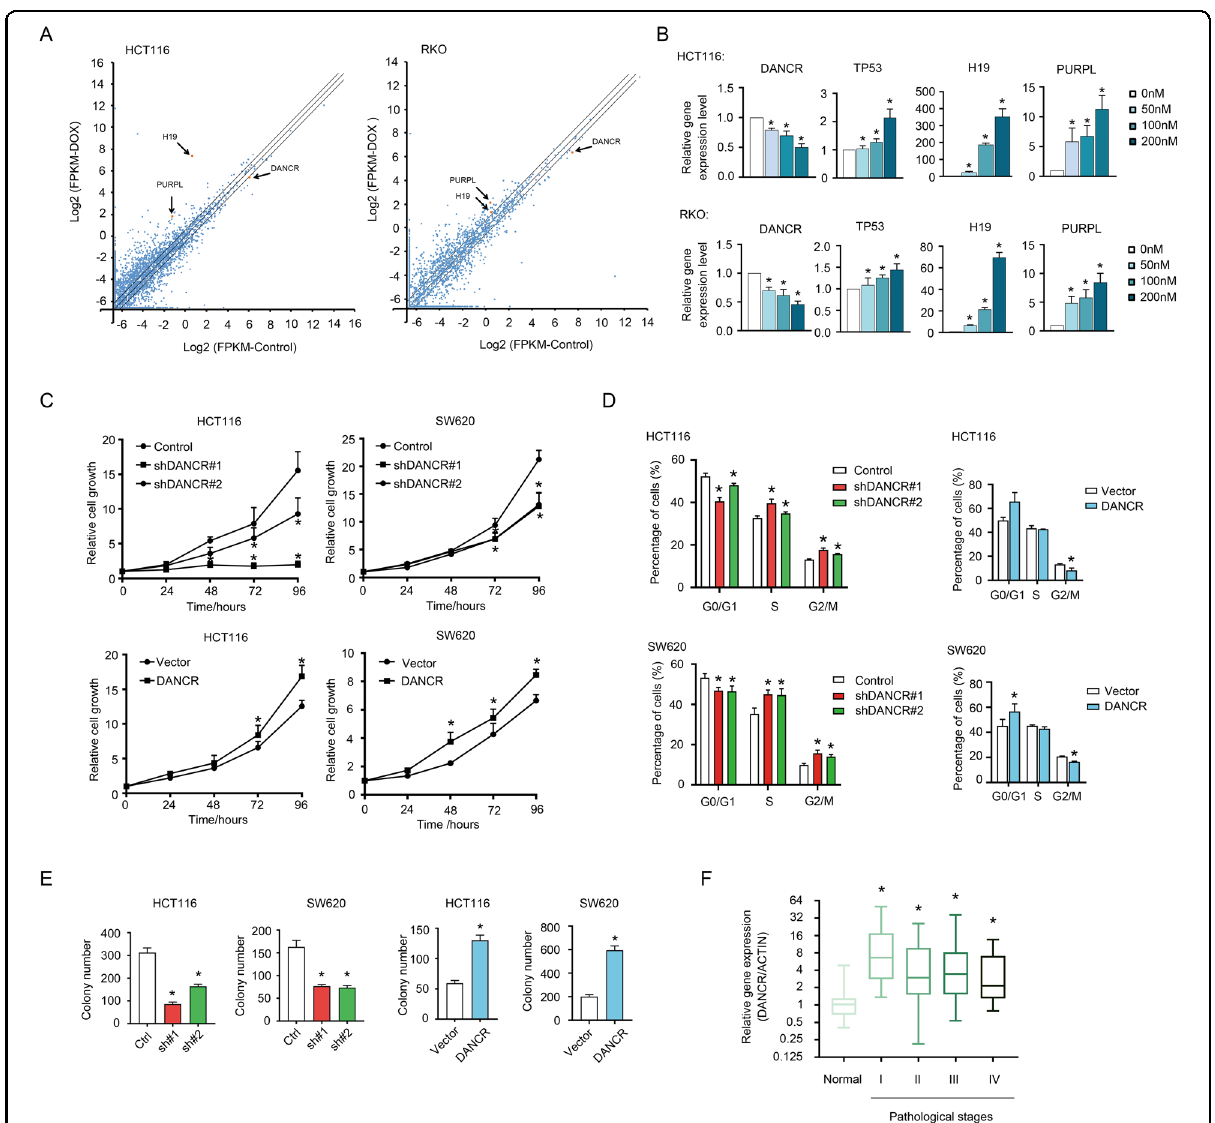
Fig. 1 DANCR was closely correlated with cell growth and tumor progression in colorectal cancer. A Changes in lncRNA expression in HCT116 and RKO cells upon Dox treatment were presented in Scatter Dot Plots. X axis: log 2 (FPKM) of control cells; Y axis: log 2 (FPKM) of Dox-treated cells. Arrows indicated lncRNAs DANCR, PURPL, and H19, whose fold changes were higher than 1.5-fold. B The expression levels of DANCR, TP53, H19, and PURPL were detected by qPCR in HCT116 (top) and RKO (bottom) cells treated with increasing dosages of Dox (0, 50, 100, 200 nM) for 24 h. * p < 0.05. C DANCR knockdown inhibited HCT116 and SW620 cells proliferation (top), whereas DANCR overexpression promoted the growth of HCT116 and SW620 cells detected by CCK8 assays (bottom). * p < 0.05. D Cell cycle progression was analyzed using fl ow cytometry in HCT116 and SW620 cells with shDANCR or DANCR overexpression vectors. * p < 0.05. E The anchorage-independent growth capacity of HCT116 and SW620 cells was impaired upon DANCR knockdown, and it was enhanced in HCT116 and SW620 cells overexpressing DANCR. * p < 0.05. F Relative expression levels of DANCR in colorectal cancer tissues of different pathological stages. Normal, adjacent noncancerous tissues ( n = 18). I – IV: TNM stages I ( n = 21), II ( n = 40), III ( n = 44), and IV ( n = 21). * p <